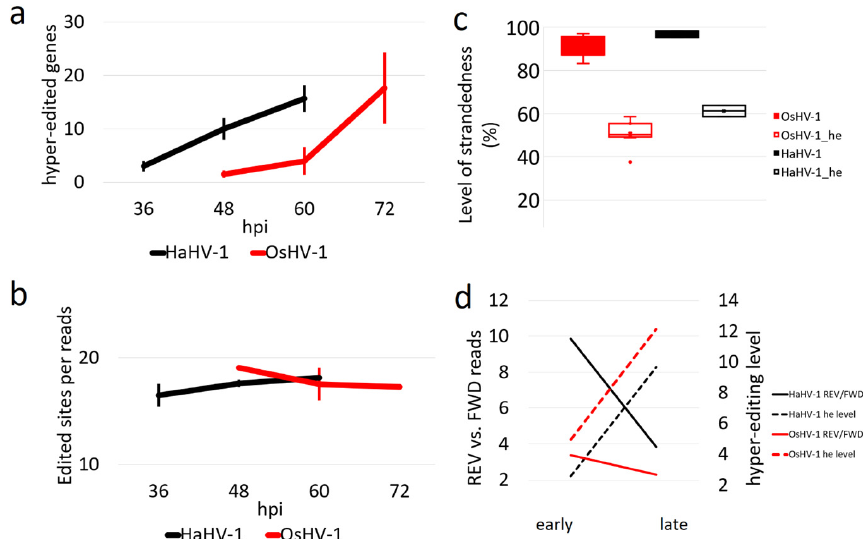
Figure 5. ADAR hyper-editing. ( a ) Box plot with the number of genes impacted by a minimal hyper-editing of 5‰. ( b ) Hyper-editing efficiency measured as the average number of edited sites per hyper-edited read. ( c ) Library strandedness computed considering either the bulk reads or the hyper-edited (he) reads mapped on the viral transcripts. ( d ) Comparison between the mean transcript strandedness and hyper-editing levels in early and late infection points for the genes showing at least 5 hyper-edited reads per 1000 mapped reads.